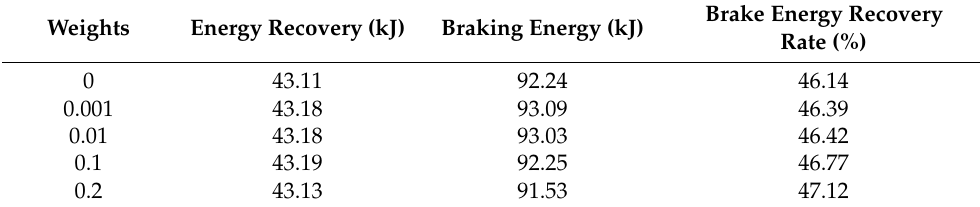
Table 5. Comparison of energy recovery rates under different efficiency weights.